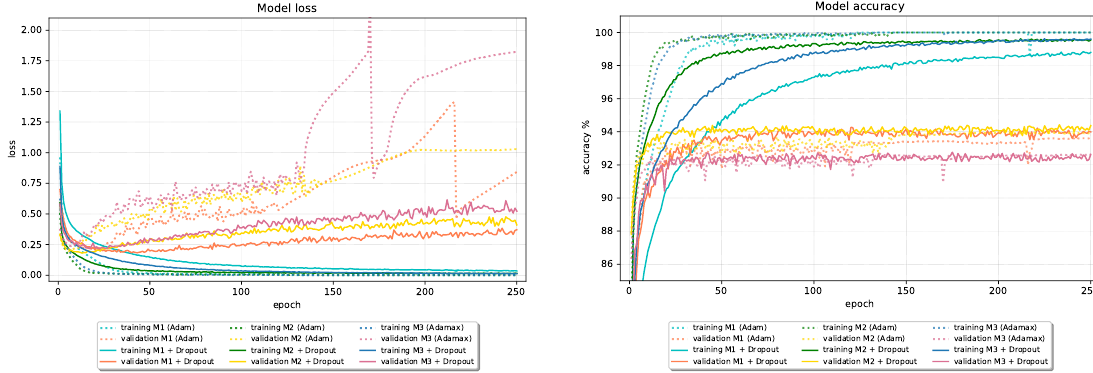
Figure 12. The effect of Dropout on baseline models trained on Fashion-MNIST dataset.